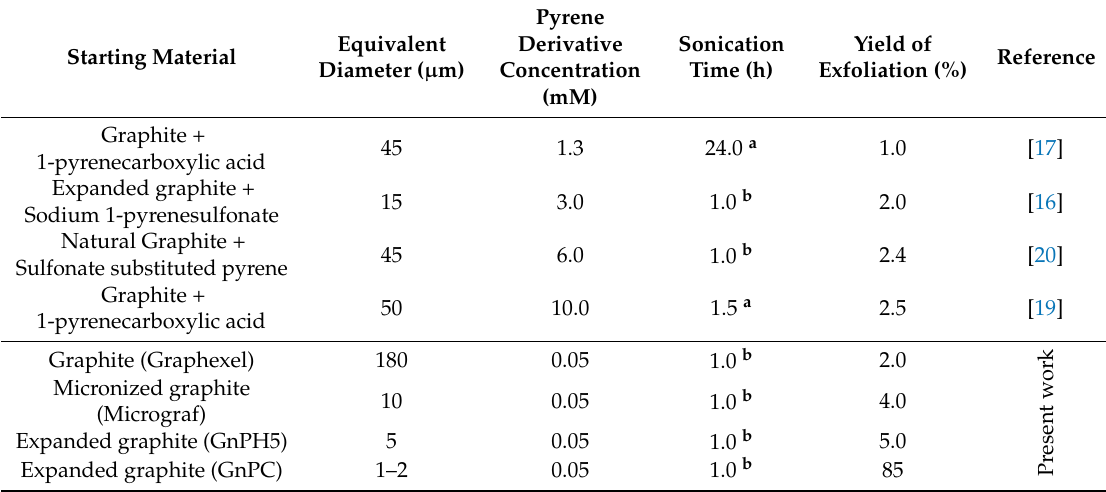
Figure 3. Concentration of few-layer graphene GnPH5, GnPC, Micrograf, and Graphexel in water as a function of time. Table 1. Yield of graphite exfoliation reported in the literature and the results obtained in the present